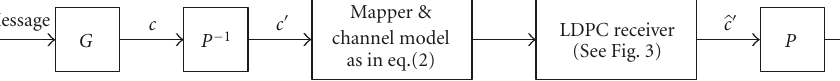
Figure 2: Communication system.